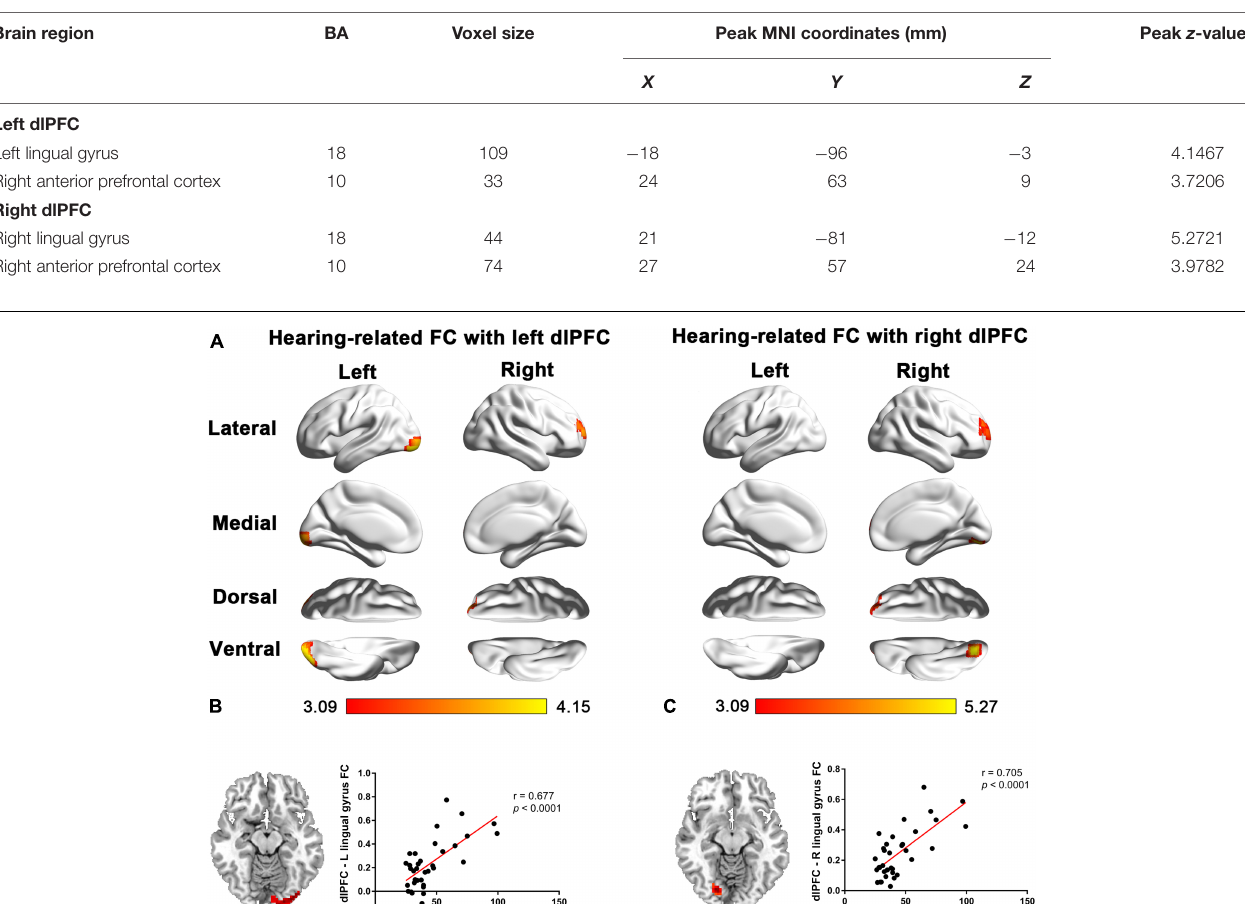
TABLE 5 | Hearing-related FC with the dlPFC in patients with SNHL.